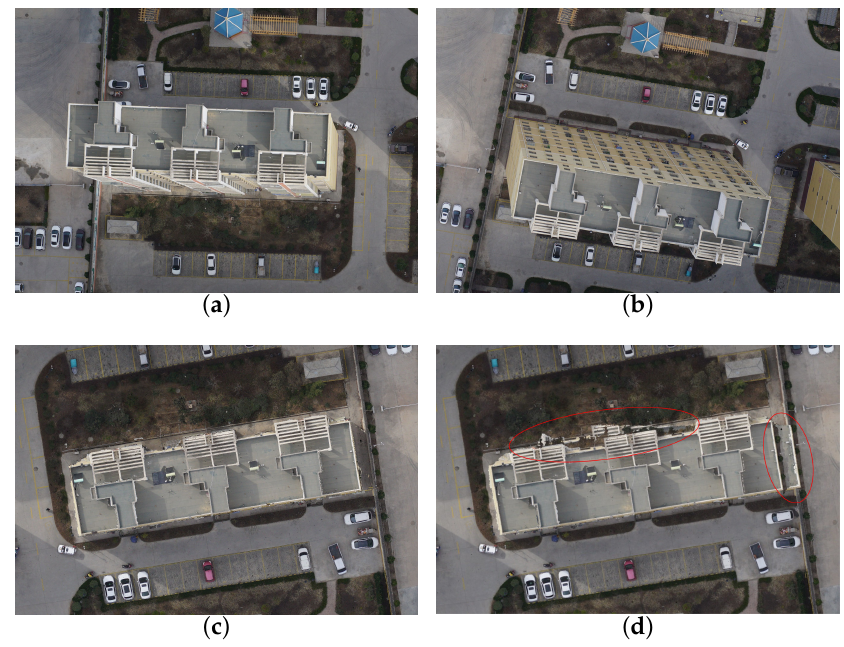
Figure 15. Digital orthophoto results generated with and without occlusion detection. We use the red ellipses to mark the incorrect texture, as shown in ( d ). ( a ) Aerial image. ( b ) Aerial image. ( c ) Result with occlusion detection. ( d ) Result without occlusion